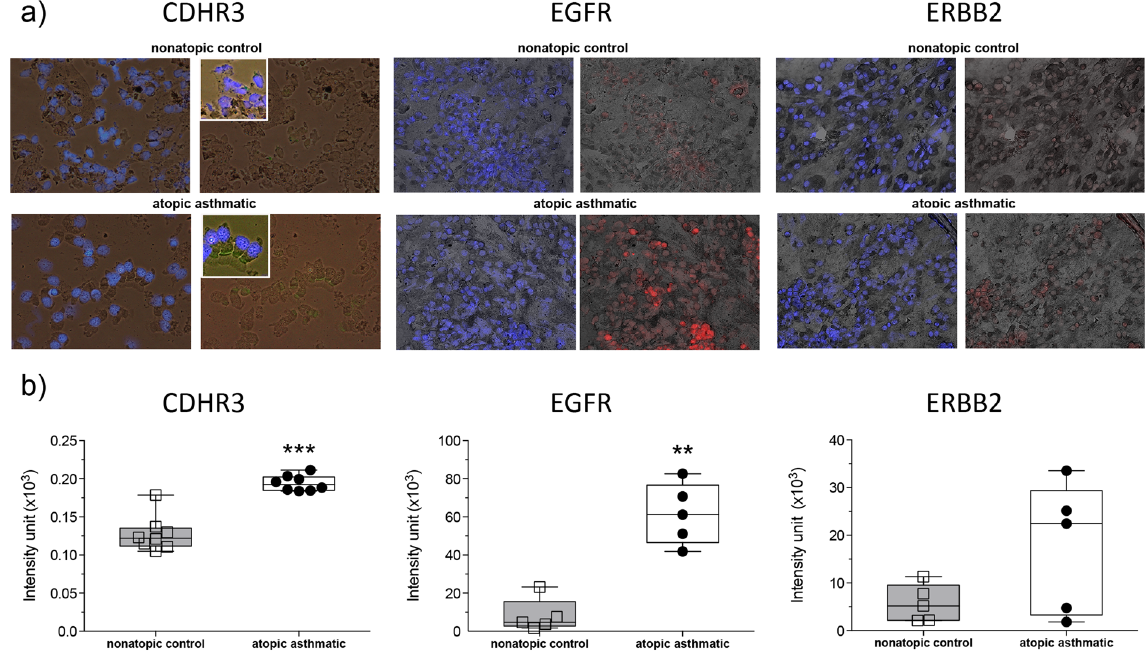
Figure 6. Increased expression of CDHR3 and EGFR in bronchial epithelial cells from HDM sensitized asthmatics versus nonatopic controls. The expression of the hub genes CDHR3, EGFR and ERBB2 was validated at the protein-level in an independent cohort. Bronchial epithelial cells were obtained from HDM sentitized atopics with asthma and nonatopic controls. ( a ) Bronchial epithelial cells were immunofluorescently stained for CDHR3 expression 23 , EGFR expression 71 , ERBB2 expression 71 and nuclei with DAPI (blue). Staining images were then overlaid over bright field images taken of the same field of view. Note: mag 200 × ; inset 400 × . ( b ) Quantification of the images demonstrated that the expression of CDHR3 and EGFR was more intense in the atopics with asthma. The expression of ERBB2 was not different between the groups. Mann-Whitney U Test was utilized to test for statistical significance. *** p-value < 0.001, ** p-value <